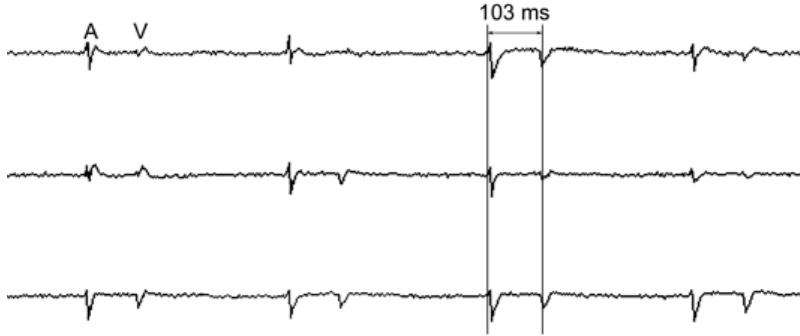
FIGURE 9. ECG recording of a murine embryo aged 10.5 days. The cardiac activation is characterized by two deflections representing atrial (A) and ventricular (V) activation, separated by a delay (103